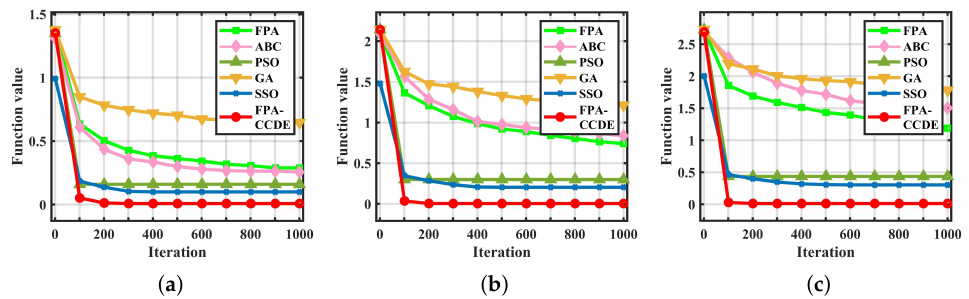
Figure 4. Fitness value graphs on F9: ( a ) the fitness value of F9 with 10 dimensions; ( b ) the fitness value of F9 with 20 dimensions; ( c ) the fitness value of F9 with 30 dimensions.